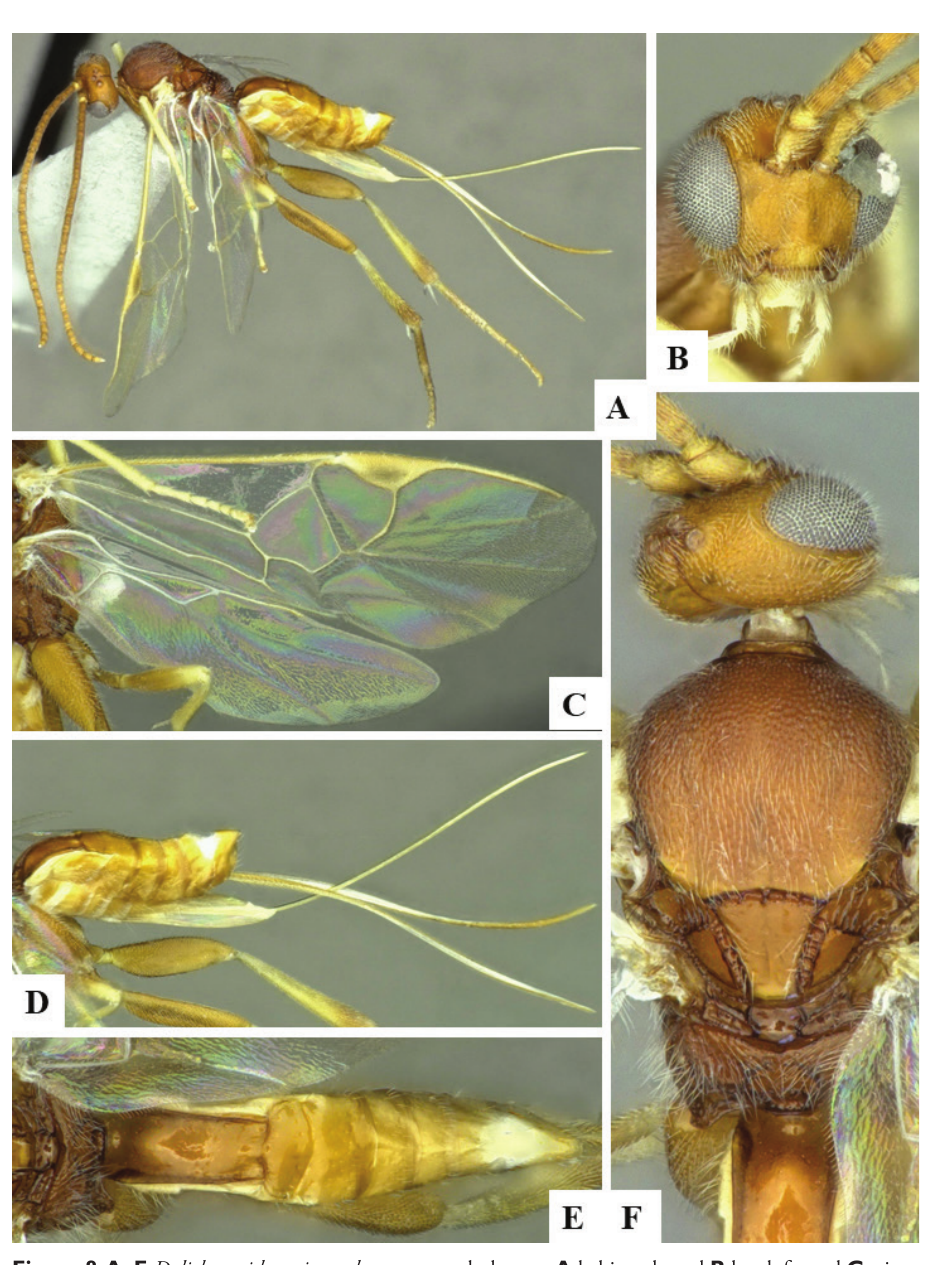
Figure 8. A–F Dolichogenidea yeimycedenoae sp. n., holotype. A habitus, lateral B head, frontal C wings D metasoma, lateral E metasoma, dorsal F head and mesosoma,